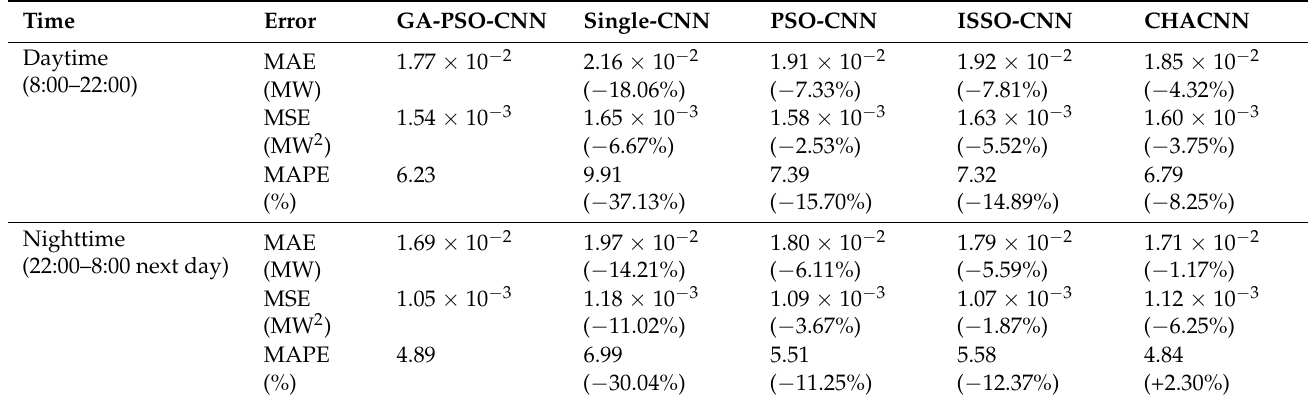
Table 4. Prediction error of each model in different time